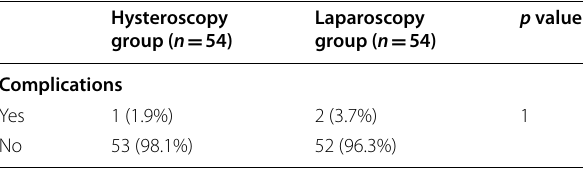
Table 4 The operative complications in the studied